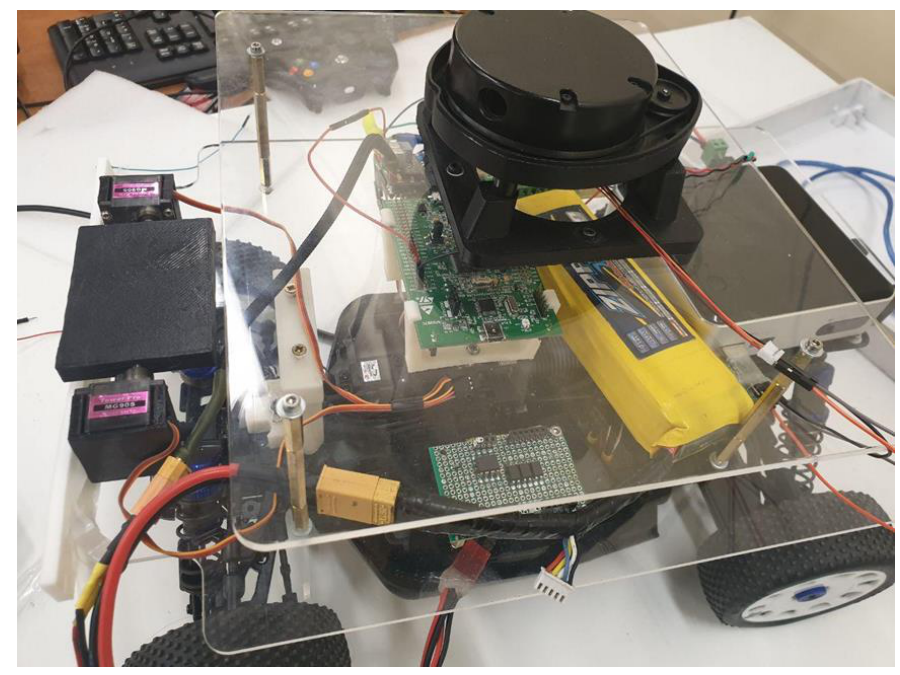
Fig. 3. Educational mobile robot